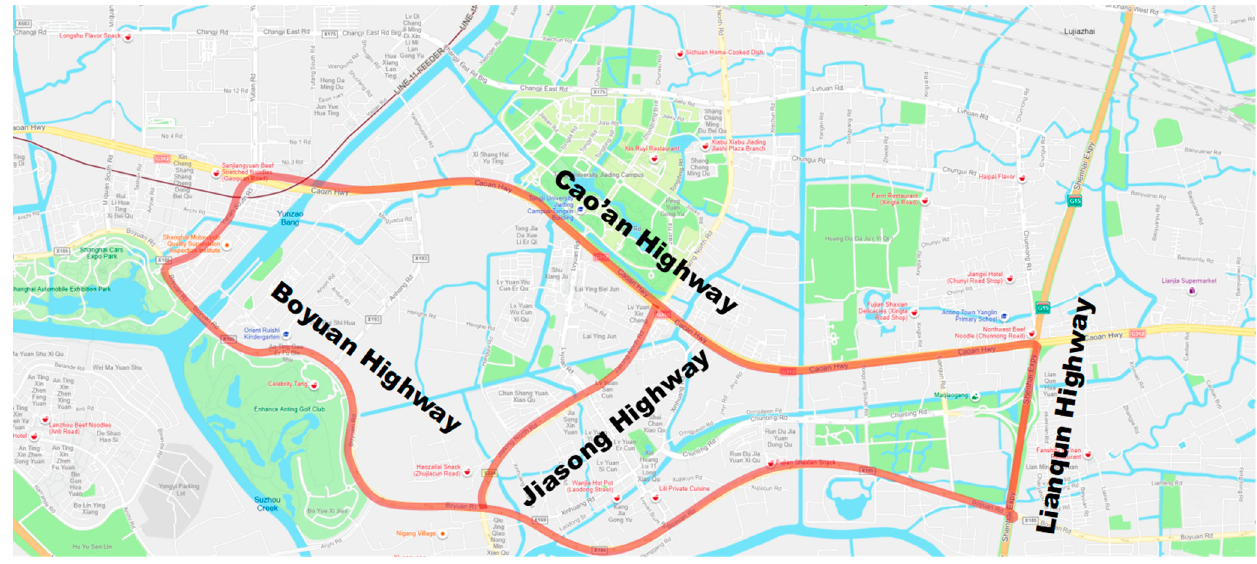
Figure 12. The tested highways. Table 3. Scenarios for water-film thickness estimation.